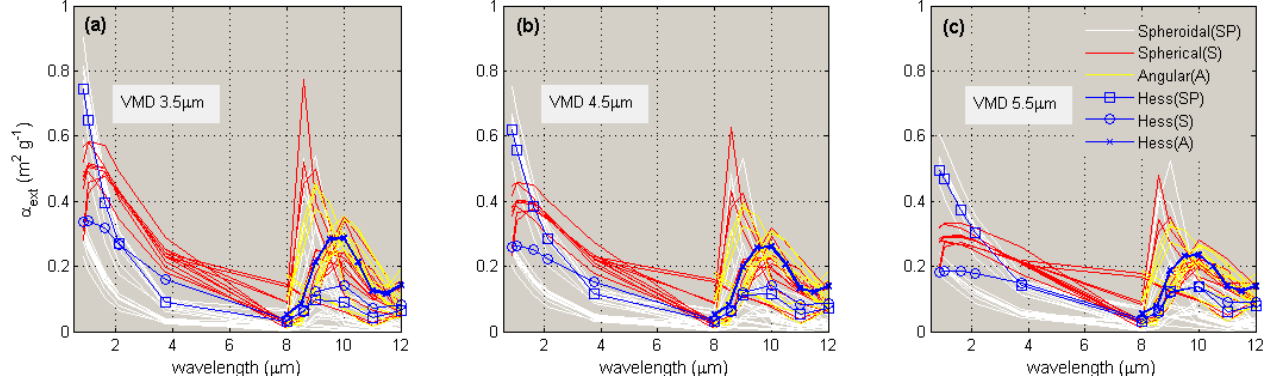
Fig. 6. Dust MEE over all particle shapes, compositions and wavelengths (channels) with VMD corresponding to the frequently observed size range of (a) 3.5µm, (b) 4.5µm, and (c) 5.5µm. Shapes consist of oblate and prolate spheroids (SP) with aspect ratios of 1.8 and 0.5, respectively, spheres (S), and angular particles (A), calculated only for IR wavelengths for all 13 mineral compositions. The Hess/OPAC dust model is represented by the blue curves.